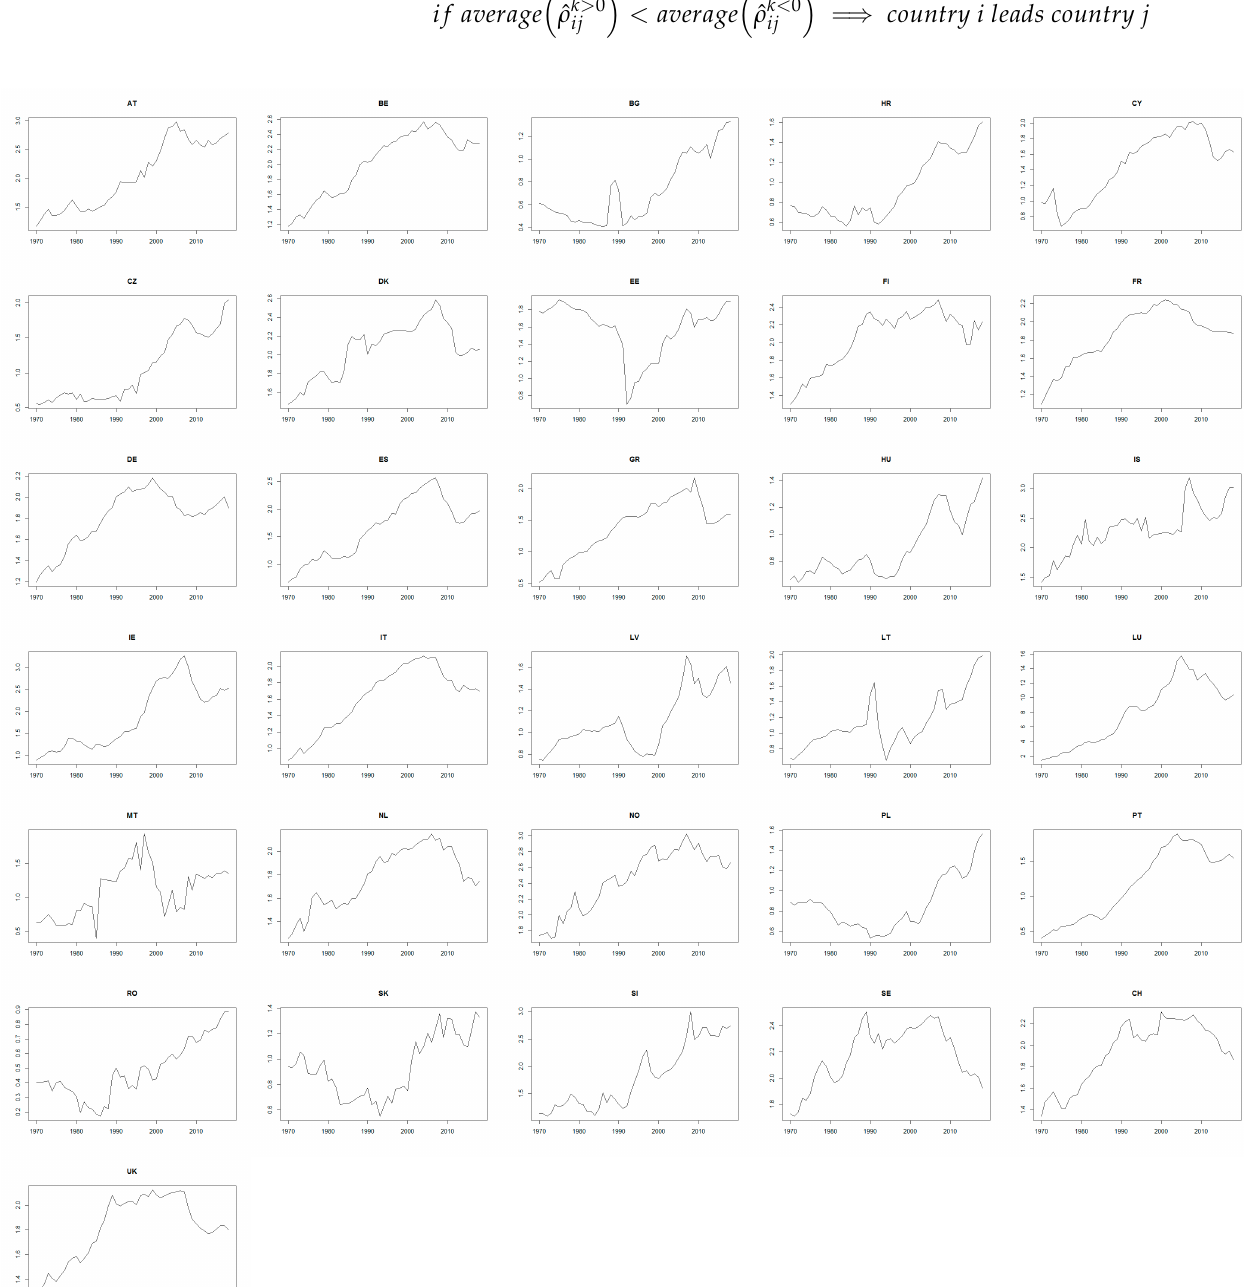
Figure 1. Time-series plot of the annual CO 2 emissions from 1970 to 2018.